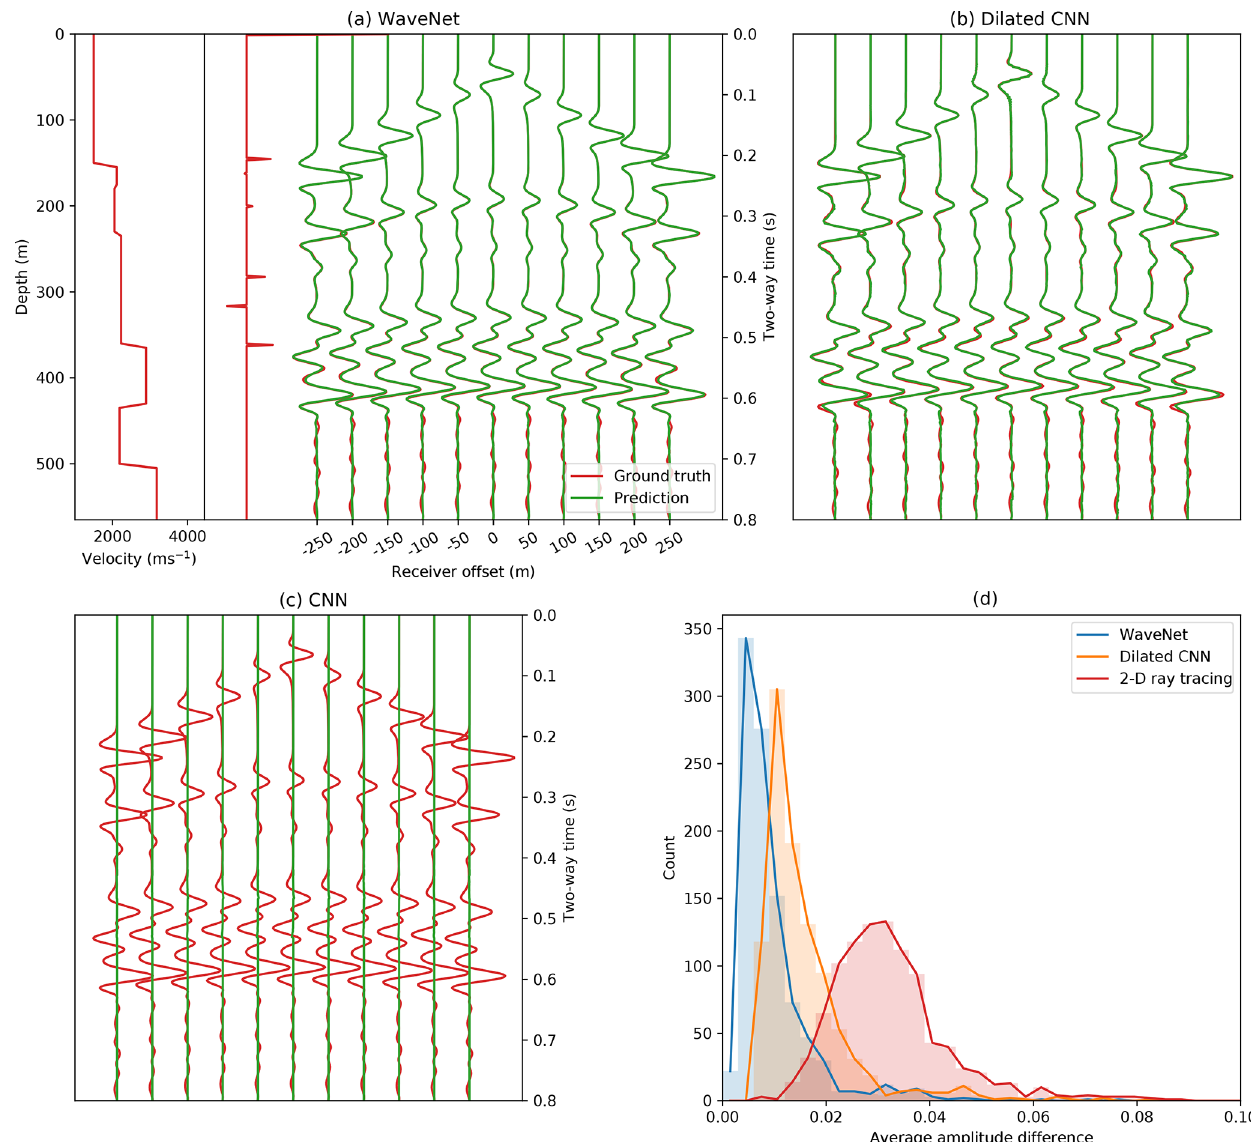
Figure A1. Comparison of different network architectures on simulation accuracy. (a) The WaveNet simulated pressure response for a randomly selected example in the test set (green) compared to ground truth FD simulation (red). (b, c) The simulated response when using two convolutional network designs with and without exponential dilations. (d) The histogram of the average absolute amplitude difference between the ground truth FD simulation and the simulations from the WaveNet, the dilated convolutional network and 2-D ray tracing over the test set of 1000 examples. A t 2 . 5 gain is applied to the receiver responses for